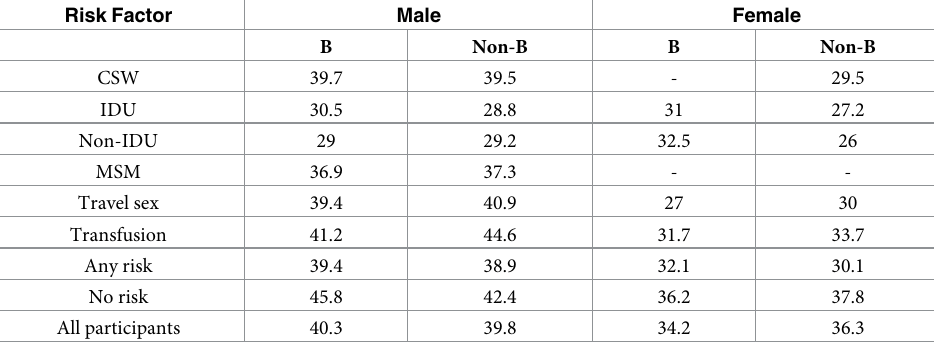
Table 5. Mean age (years) of typeable participants by gender, subtype, and self-reported risk